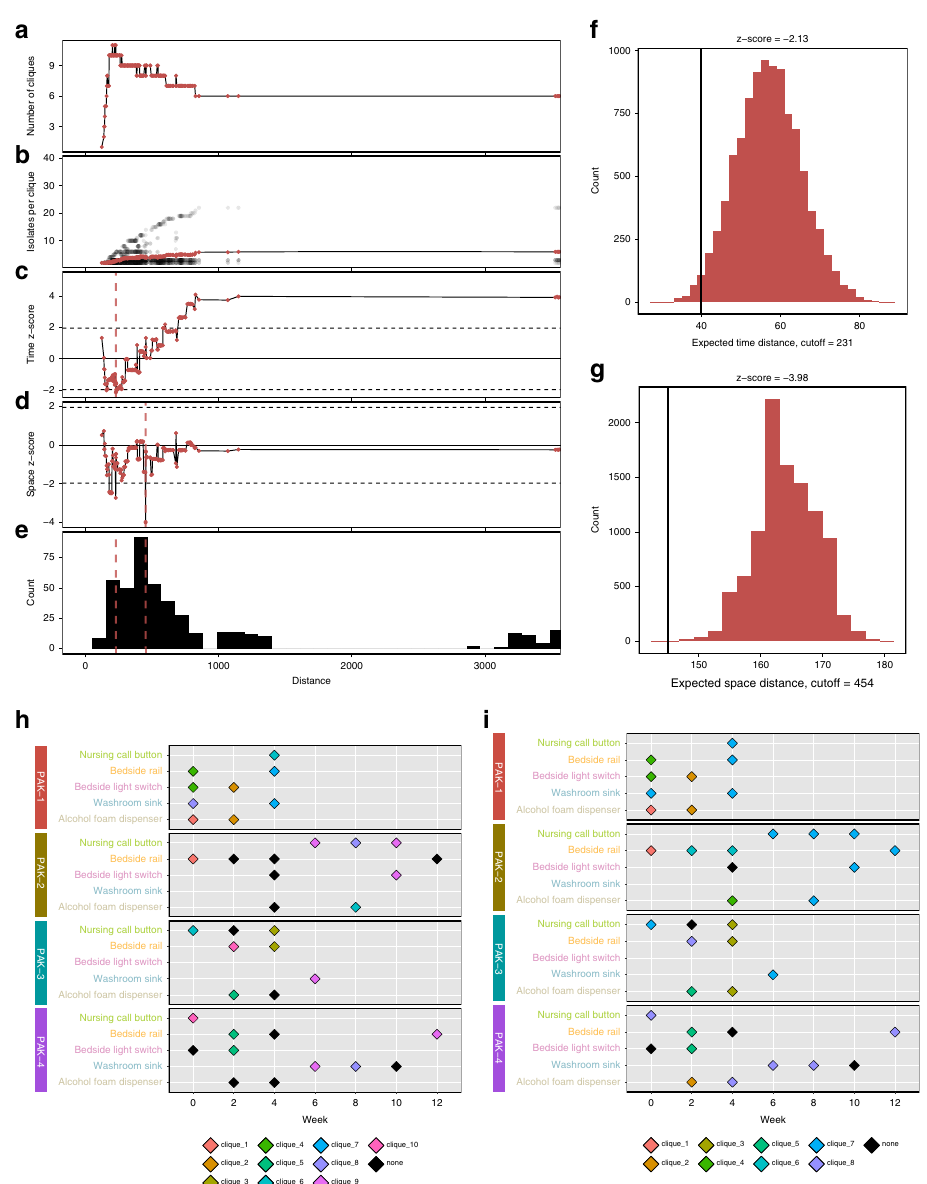
Fig. 6 E. faecium optimal pairwise variant distance cliques identi fi ed by spatial and temporal data. E. faecium isolate clique groupings with the lowest observed spatial and temporal distances compared to the expected distribution. Panels a – e give information on the clique groupings for each unique variant distance cutoff ( x -axis) starting at the minimum variant distance and extending until the minimum variant distance between two isolates from different lineages. Panel a shows the number of completely connected cliques identi fi ed at the current cutoff value. Panel b shows the number of isolates per clique, with the black dots showing each individual clique and the red points showing the average per clique. Panels c and d show the deviation ( z -score given as red points) of the observed temporal ( c ) or spatial ( d ) distance compared to the expected distribution. The dotted lines show the upper and lower signi fi cance bounds. e Histogram of the number of pairwise comparisons in different variant distance cutoff ranges. Red dashed lines show the minimum z - score cutoffs for the temporal and spatial distances given in c and d . Panels f and g show the observed distance value vs the expected distribution for the minimum z -score values identi fi ed in c and d for temporal ( f ) and spatial ( g ) distance. The black vertical line is the observed distance and red fi lled histogram is the expected distribution. Panels h and i show the show the cliques identi fi ed at the minimum z -score cutoffs for temporal ( h ) and spatial ( i ) distance measurements. Source data for all panels are provided in the source data fi